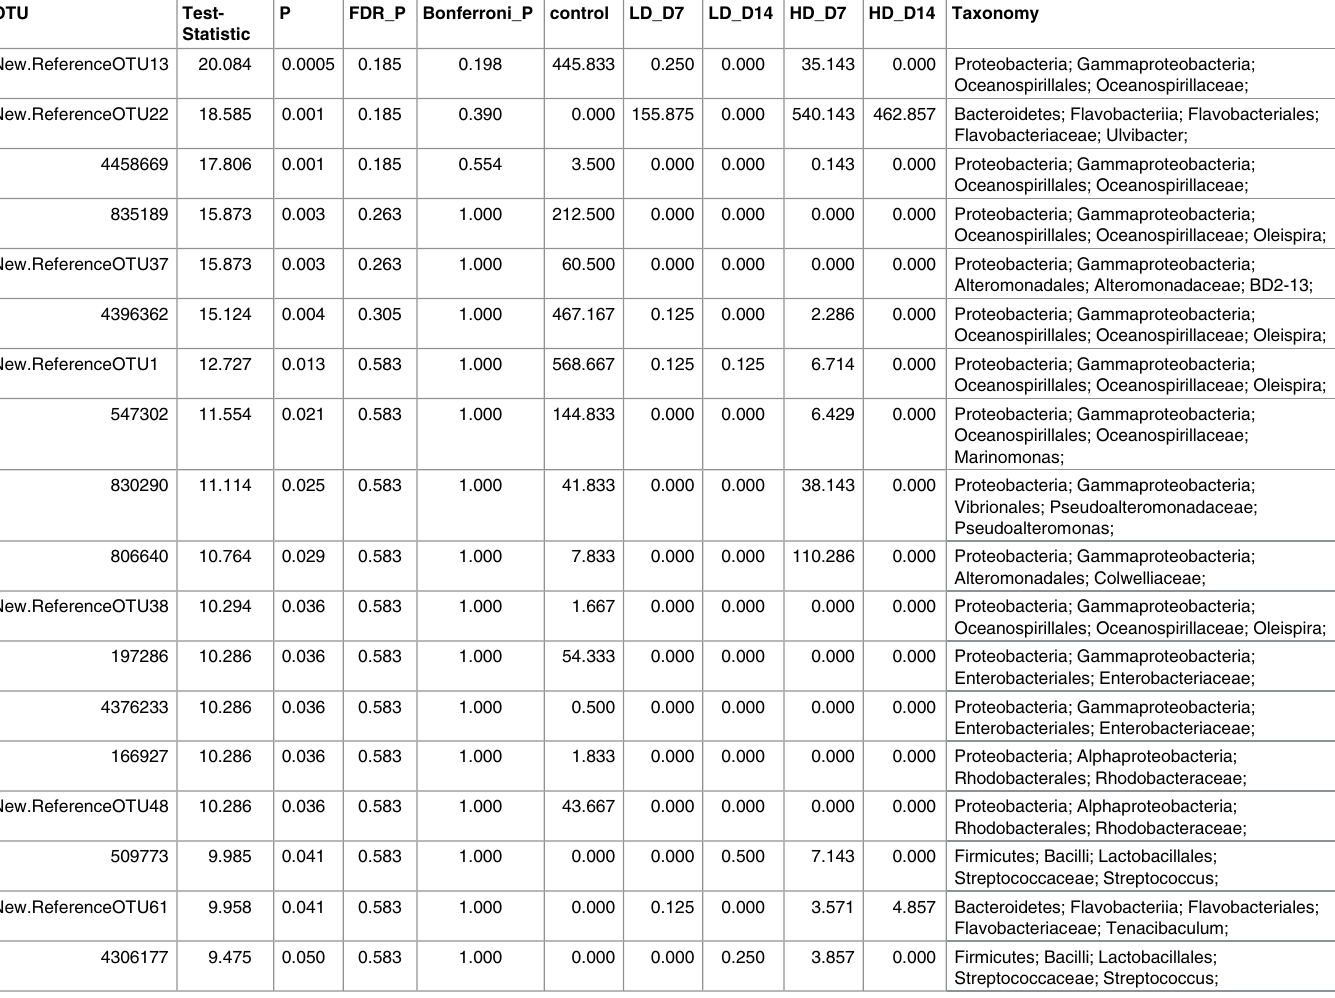
Table 2. List of OTUs with significantly different abundances among experimental groups in this